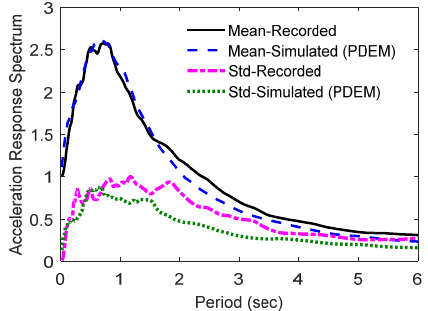
Figure 7. Comparisons of the mean and standard deviation of response spectrum of simulated seismic ground motions and those of recorded seismic ground motions.